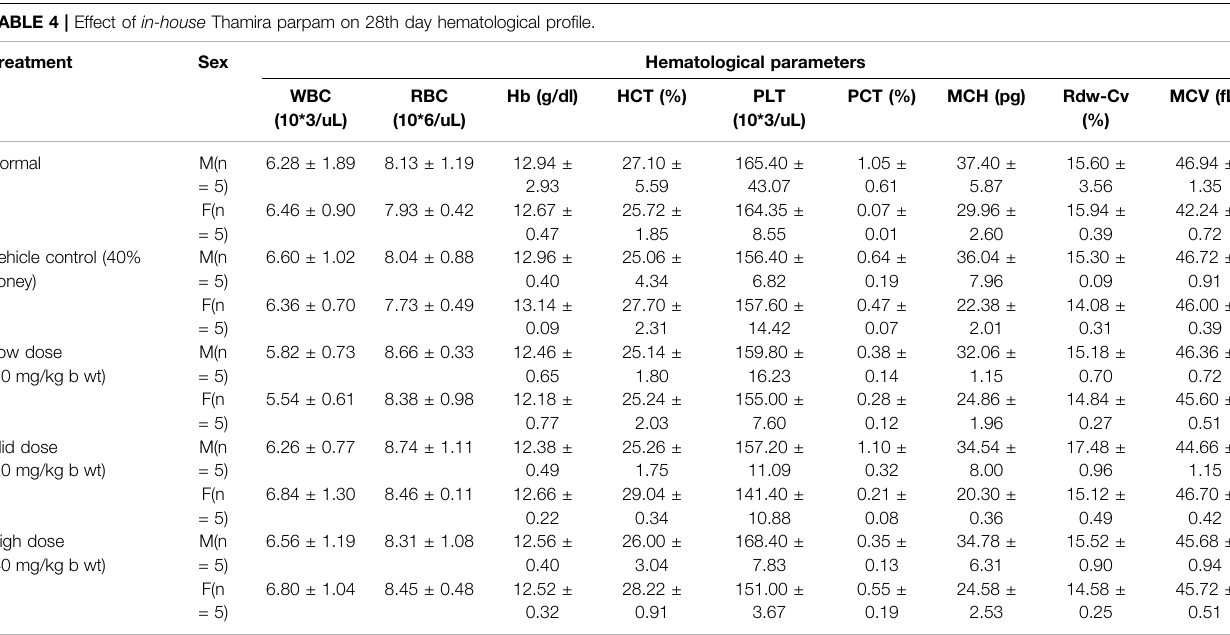
TABLE 4 | Effect of in-house Thamira parpam on 28th day hematological pro fi le.